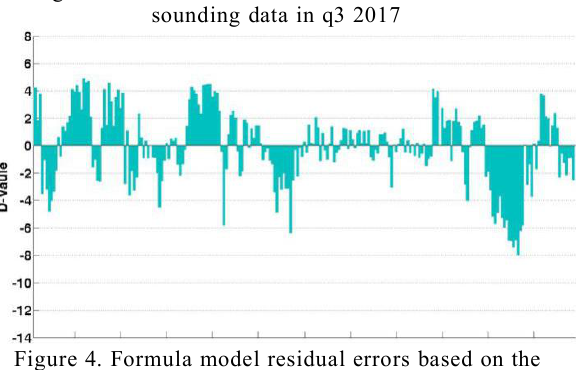
Figure 4. Formula model residual errors based on the sounding data in the whole year of